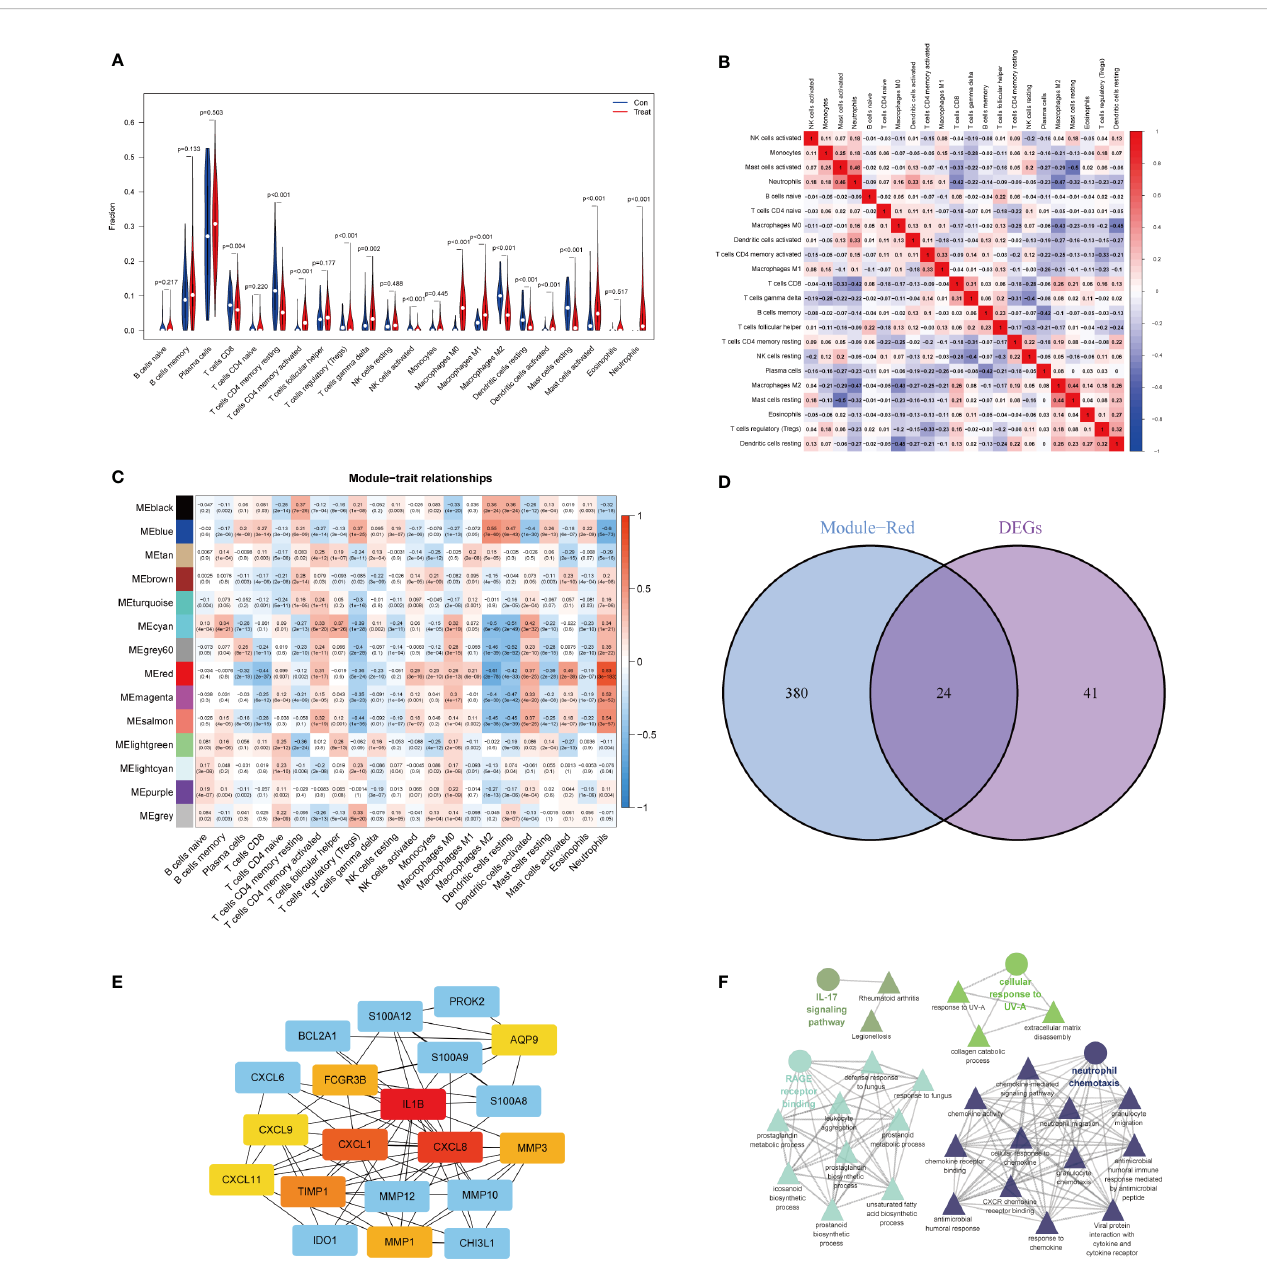
FIGURE 2 Identi fi cation of neutrophil-associated differentially expressed genes (NADEGs). (A) Comparison of signi fi cantly different immune cell in fi ltration in UC and healthy controls. (B) Heatmap of correlations of 22 immune cells in UC samples. Red indicated positive correlations and blue indicated negative correlations. (C) Heatmap of the correlation between immune cell on module genes by WGCNA. (D) Venn diagram showed the neutrophil-associated differentially expressed genes. (E) Subnetwork of core genes from the PPI network. Node color re fl ected the degree of connectivity (red color represented a higher degree, and blue color represented a lower degree). (F) Interaction pathway between NADEGs by Cluego. The circles represented the main enrichment